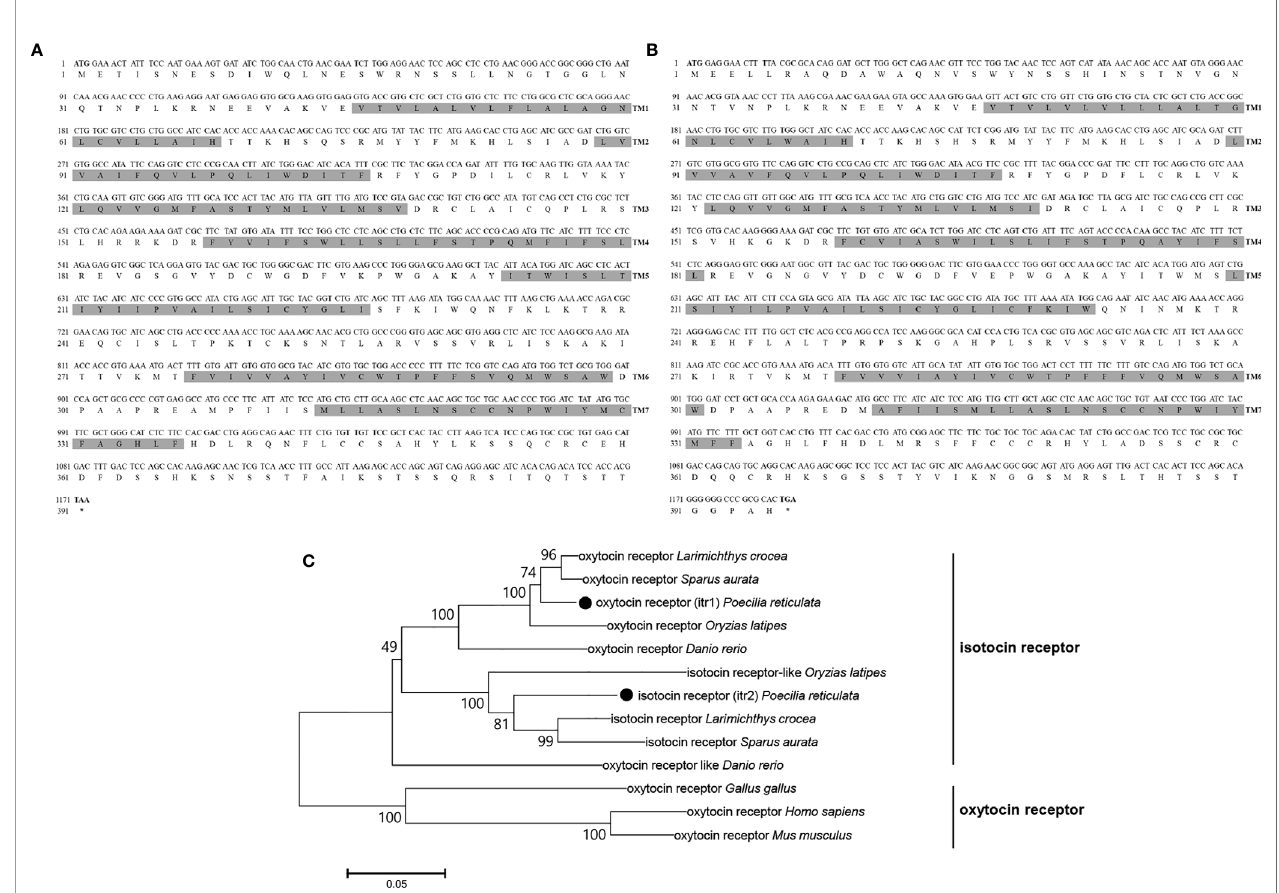
FIGURE 4 | Nucleotide and deduced amino acid sequences of guppy ITR1 (A) and ITR2 (B) . The shading represents transmembrane domains. (C) Phylogenetic analysis of the OTR family in different species. Phylogenetic tree was constructed using MEGA 6 software and the neighbor-joining method. The data were resampled with 1,000 bootstrap replicates. The accession numbers of each sequence are as follows: Carassius auratus (XP_026116839.1), Salvelinus alpinus (XP_023846756.1), Mastacembelus armatus (XP_026163763.1), ITR1 Oncorhynchus mykiss (XP_021466000.1), ITR2 Oncorhynchus mykiss (XP_021465666.1), ITR1 Seriola lalandi dorsalis (XP_023257499.1), ITR2 Seriola lalandi dorsalis (XP_023265951.1), Cynoglossus semilaevis (XP_016892293.1), ITR1 Danio rerio (NP_001186298.1), ITR2 Danio rerio (NP_001186299.1), Gallus gallus (NP_001026740.1), Homo sapiens (NP_000907.2), Mus musculus (NP_001074616.1), Oryzias latipes (NP_001243561.1), Paramormyrops kingsleyae (XP_023661236.1), Perca fl avescens (XP_028431436.1), Stegastes partitus (NP_001281113.1), Poecilia formosa (XP_007570475.1), and Paralichthys olivaceus